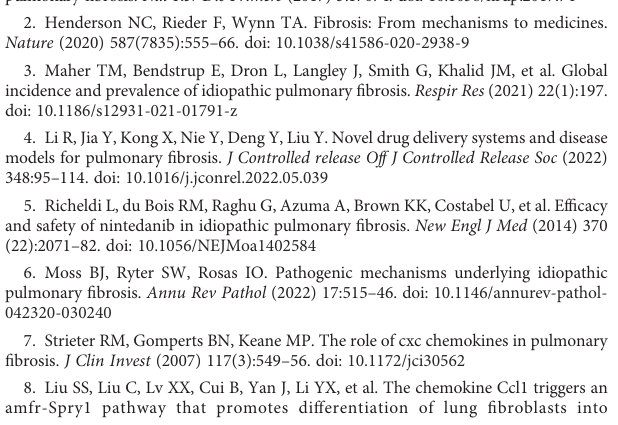
SUPPLEMENTARY FIGURE 1 PPI network of CR-DEGs using the STING database. SUPPLEMENTARY FIGURE 2 GO and KEGG enrichment analysis of CR-DEGs. (A) GO enrichment analysis of CR-DEGs, including BP. (B) KEGG enrichment analysis of CR-DEGs. SUPPLEMENTARY FIGURE 3 Independent experiments of treatment of MRC-5 with TGF b 1 or TNF a for 24